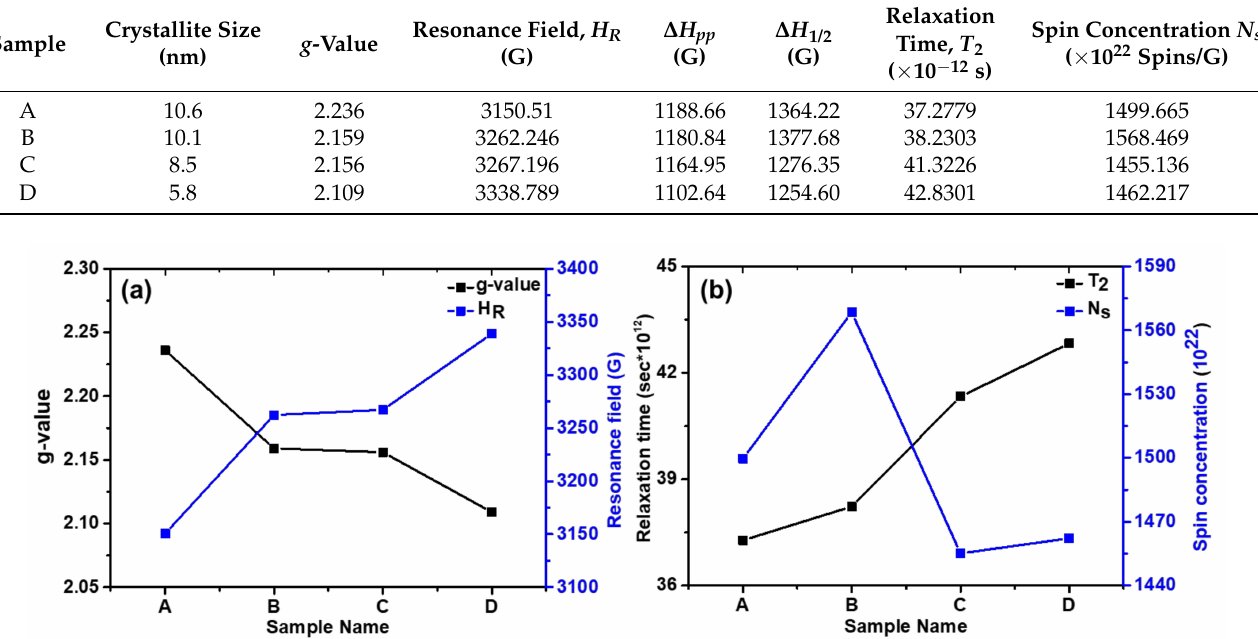
Figure 12. Variation of: ( a ) g-value and resonance field; ( b ) relaxation time and spin concentration of the AMF